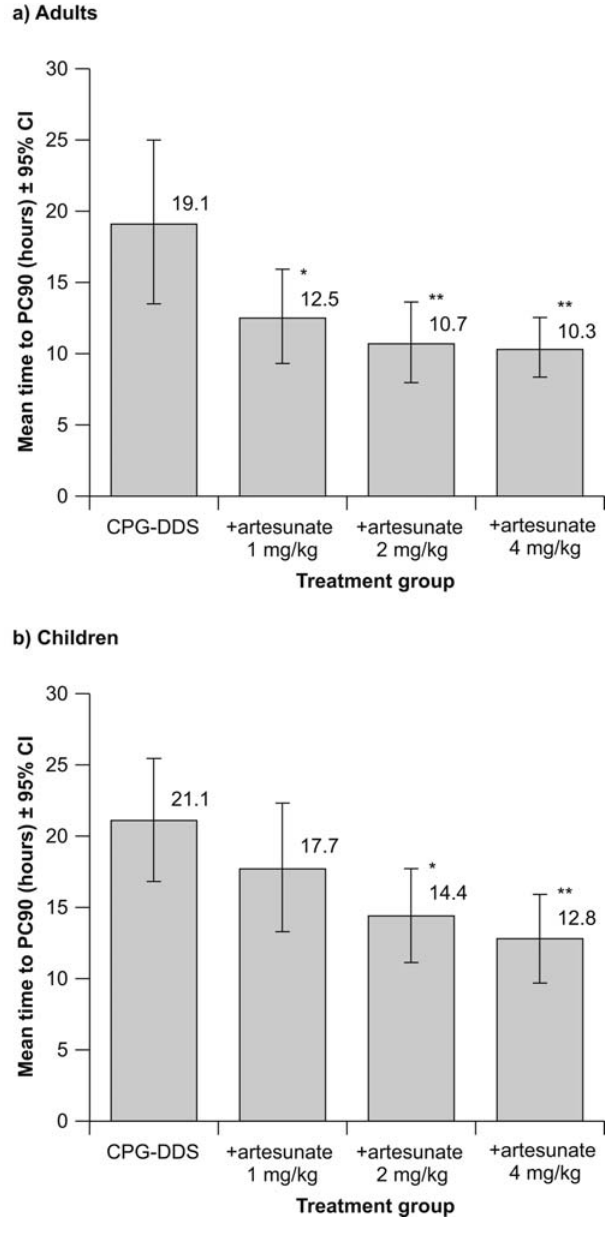
Figure 2. Primary efficacy outcome: mean time to PC90 ( 6 95% confidence intervals) in the Day 3 per-protocol population for (a) adults and (b) children. *P # 0.05 versus CPG 2 DDS alone; ** P # 0.01 versus CPG–DDS